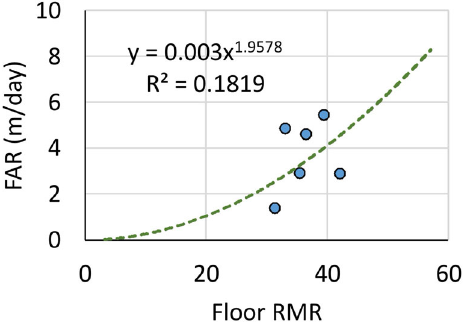
Fig. 14 Relationship between floor RMR and FAR, a linear regres- sion analysis